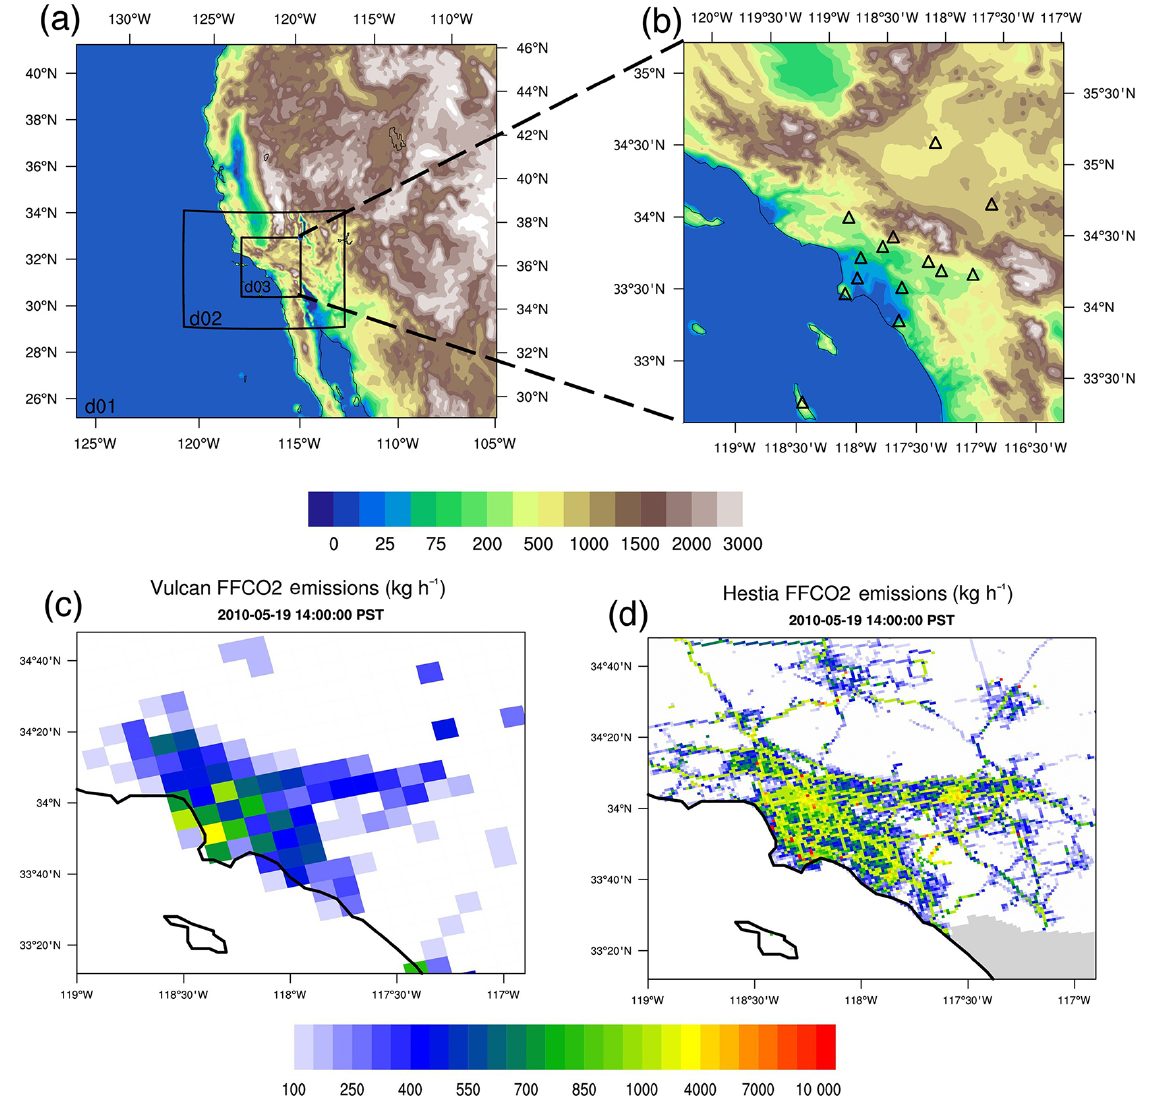
Figure 1. (a) Model domains. Contours are terrain height (unit: m). (b) The 1.3km model domain (d03) and terrain height (unit:m). Triangles represent the locations of the GHG measurement sites. (c, d) Snapshots of the Vulcan and Hestia FFCO 2 emissions (unit:kgh − 1 ) over the LA megacity at 14:00PST on 15 May